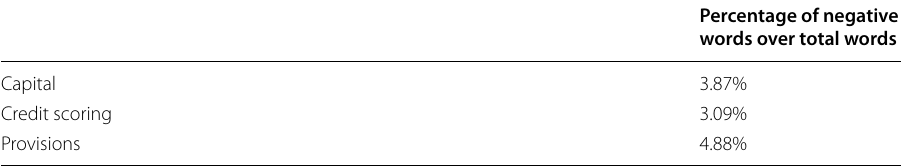
Table 10 Percentage of negative words over